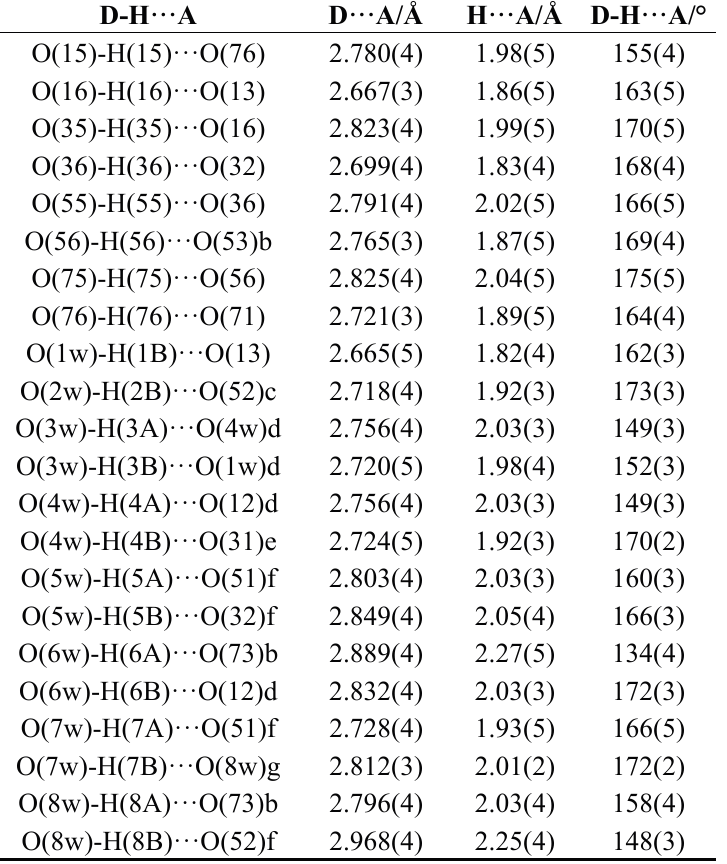
Table 3. Relevant hydrogen bonds a for Compound 2a .